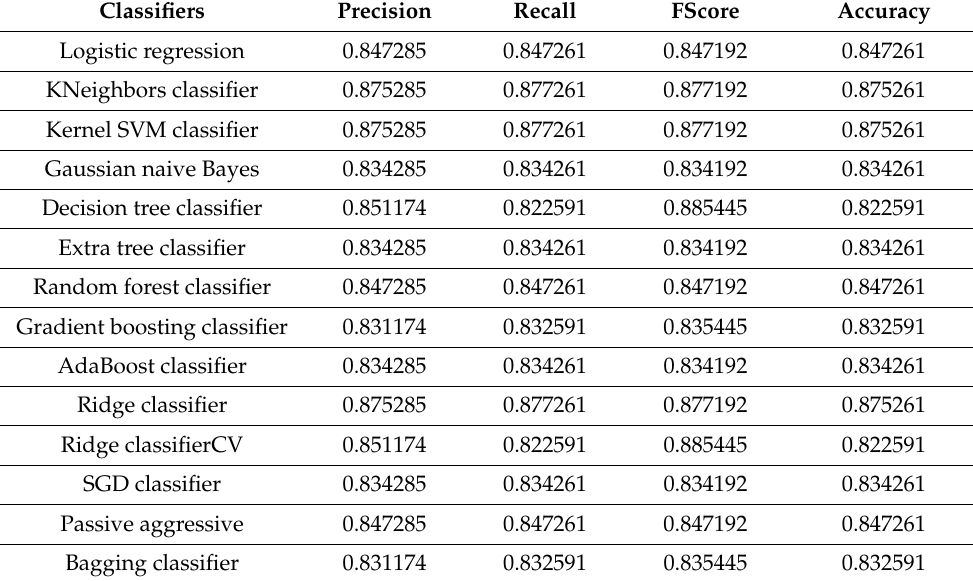
Table 24. Random forest classifier metrics after feature scaling.